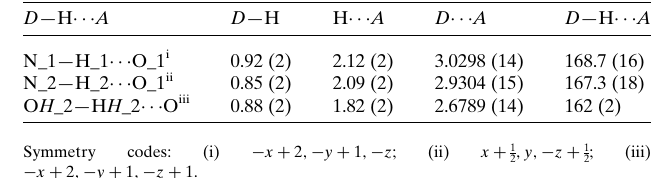
Table 2 Hydrogen-bond geometry (A˚ , (cid:5) ) for I .